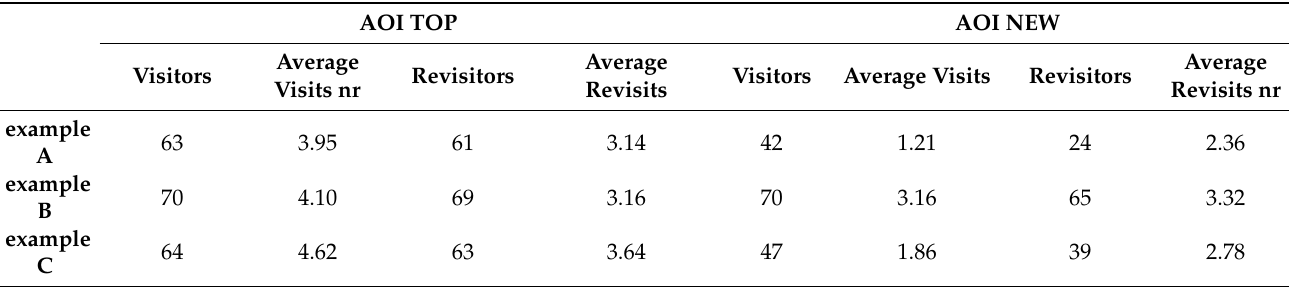
Table 3. Numbers of visitors and revisitors with average numbers of visits and revisits for AOI TOP and AOI